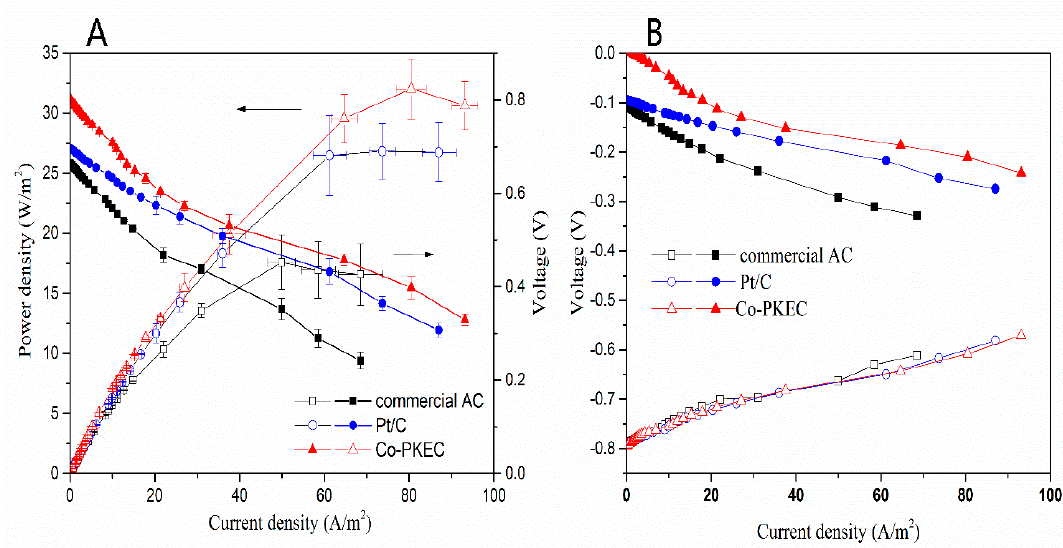
Figure 10. Power density curve ( A ) and electrode polarization curves ( B ) of fuel cell with Co-PKEC, activated carbon and commercial Pt/C as cathode electrodes.